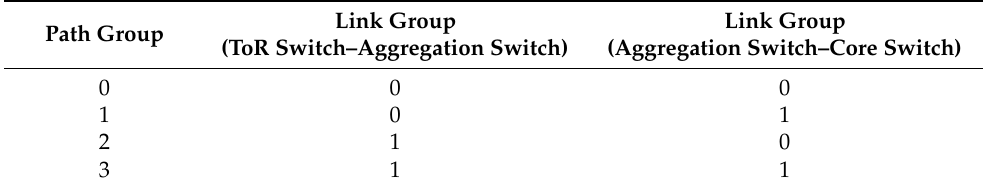
Figure 2. Illustration of partitioning 16 equal-cost paths into four symmetric path groups. Table 1. Path groups and link groups in 8-ary fat-tree.